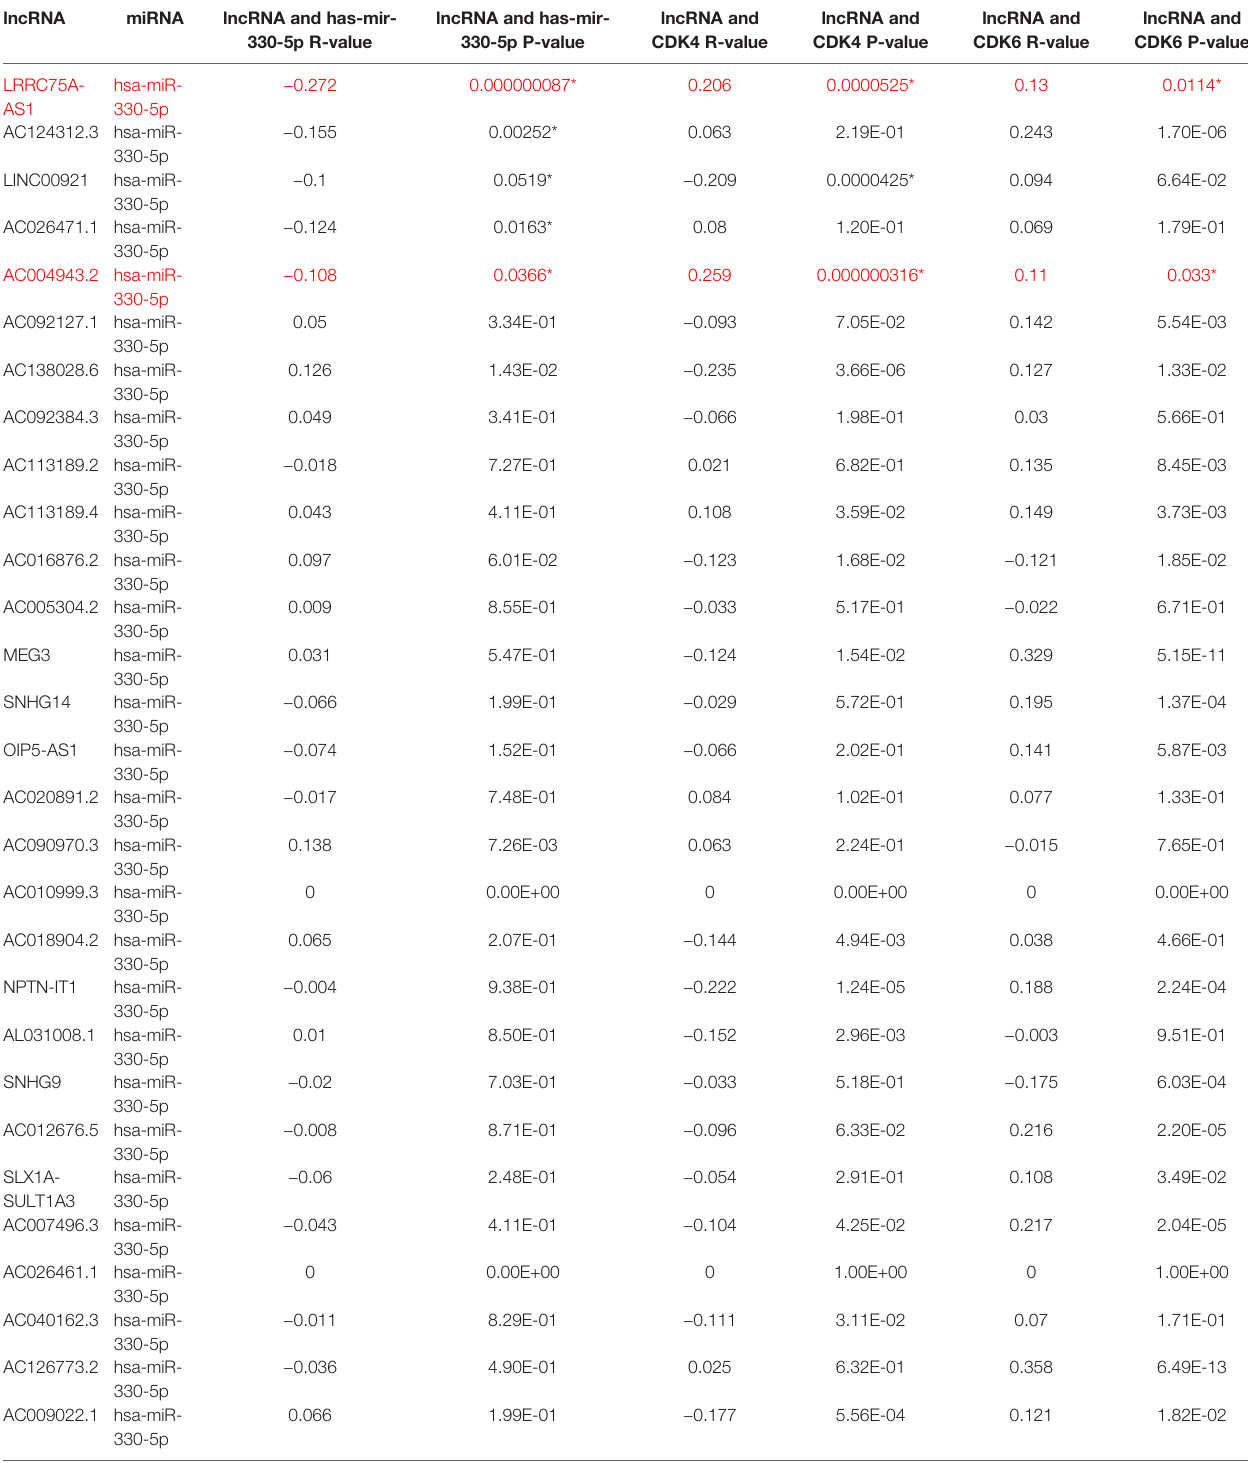
TABLE 2 | Correlation analysis between lncRNA and has-mir-330-5p or lncRNA and CDK4/6 in OV determined by starBase